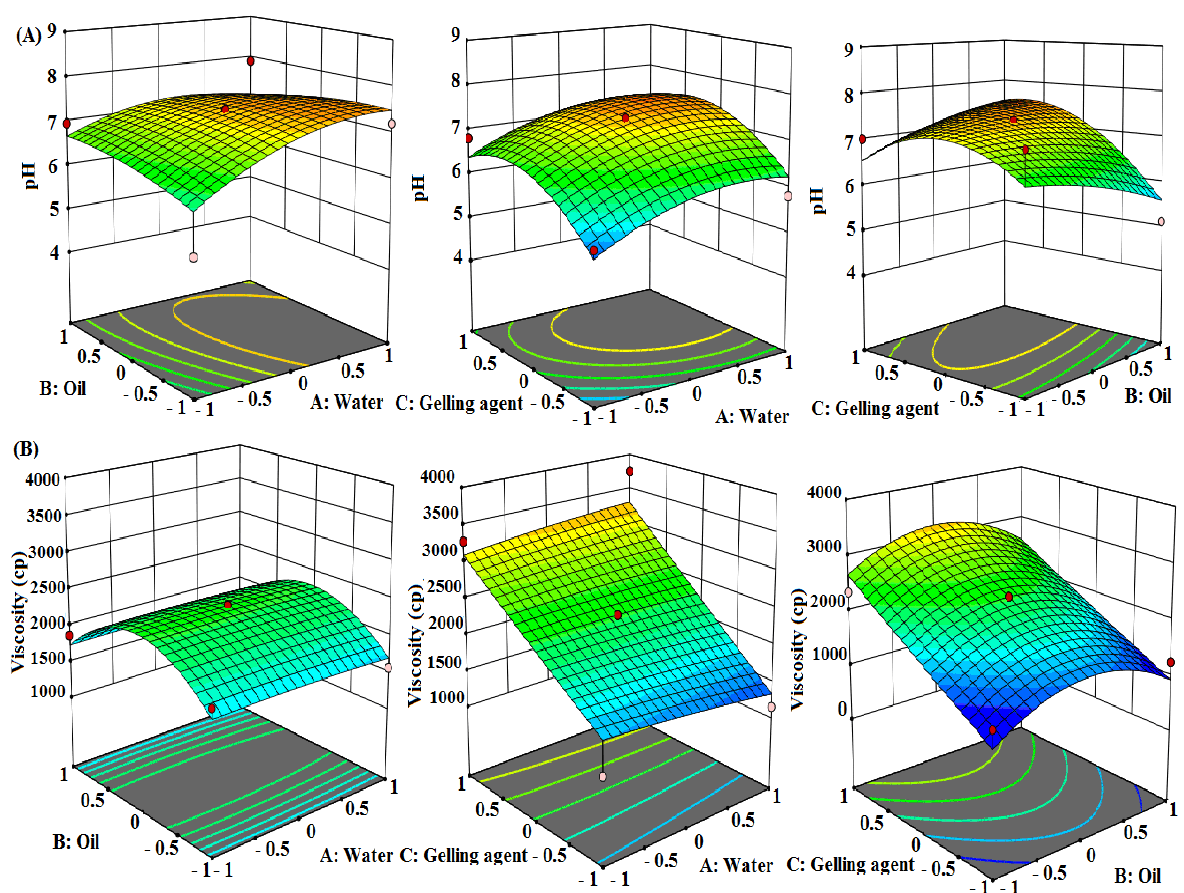
Figure 2. 3D surface plots between the factors AB, AC, and BC, showing the effects of oil, water, and polymer concentration on ( A ) pH and ( B ) viscosity.